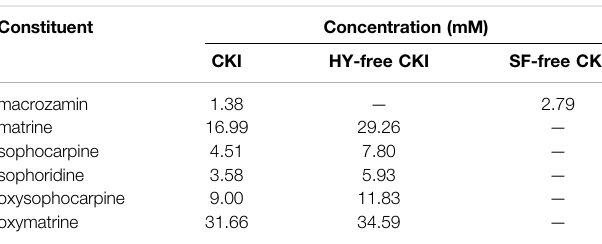
TABLE 2 | Concentrations of six constituents in